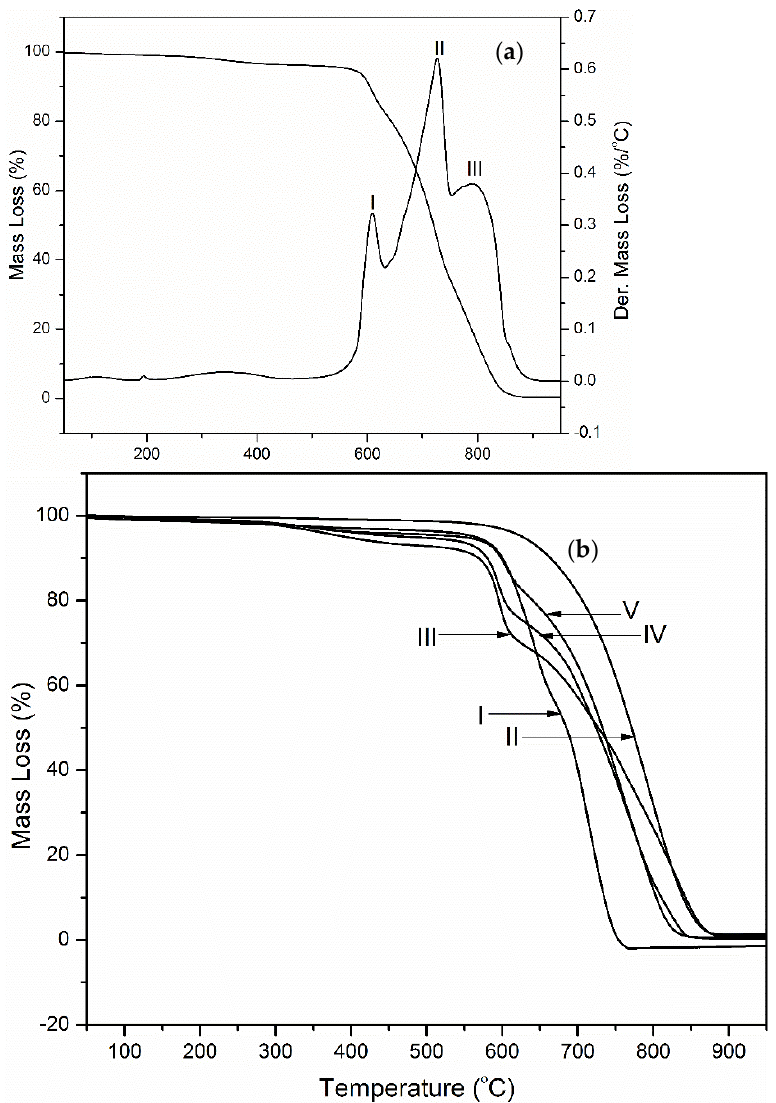
Figure 9. ( a ) Thermogravimetric and derivative mass loss curve for PI composite containing 50 wt.% graphene showing (I) the PI matrix degradation peak, (II) the PI char/graphene char degradation peak, (III) the graphene char degradation peak (in air; β = 30 ◦ C/min). ( b ) Thermogravimetric mass loss curves of (I) Neat PI (II) Graphene (III) PINGS-10 (IV) PINGS-30 (V) PINGS-50 (in air; β = 30 ◦ C/min).